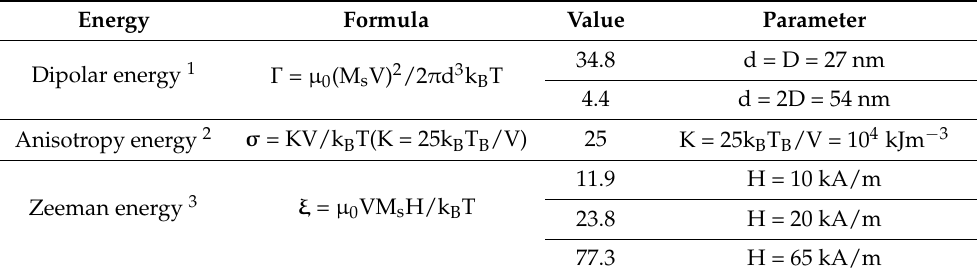
Table 3. Interaction energies normalized to the thermal